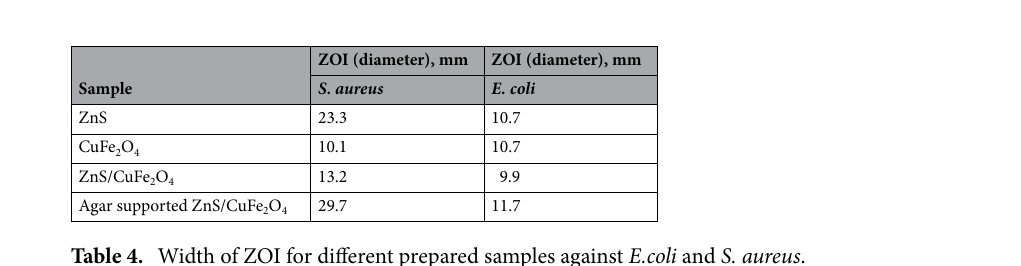
Table 4. Width of ZOI for different prepared samples against E.coli and S. aureus .